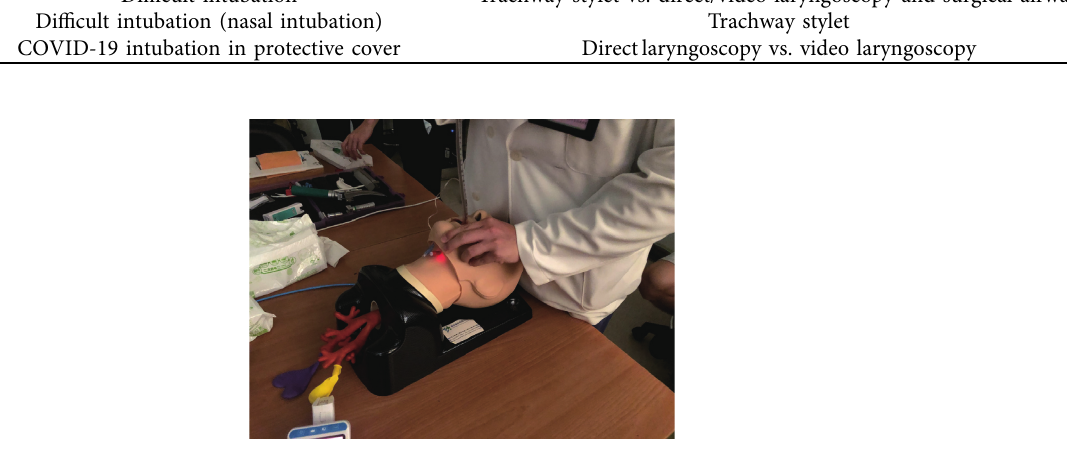
Figure 1: The tip of the Trachway intubating stylet is also equipped with the light, just like a lightwand, for guiding into the trachea by transillumination of the neck tissues.